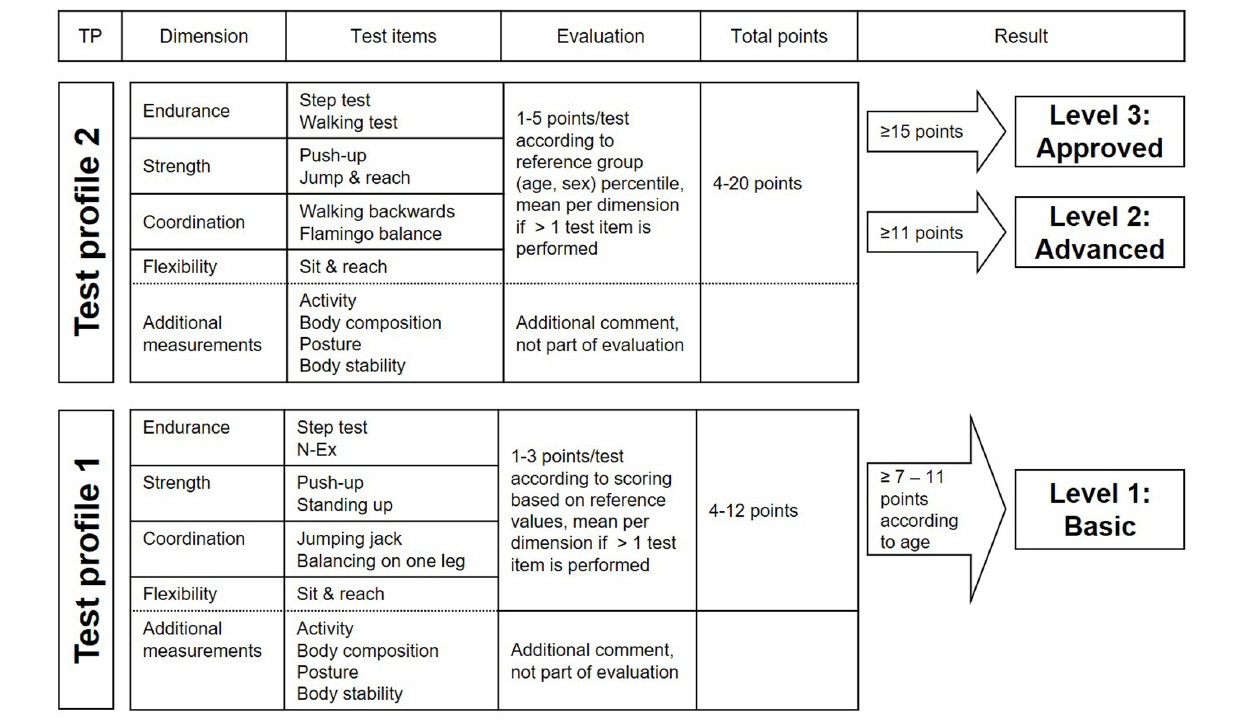
FIGURE 1 | Overview of the EFB test profiles and the according